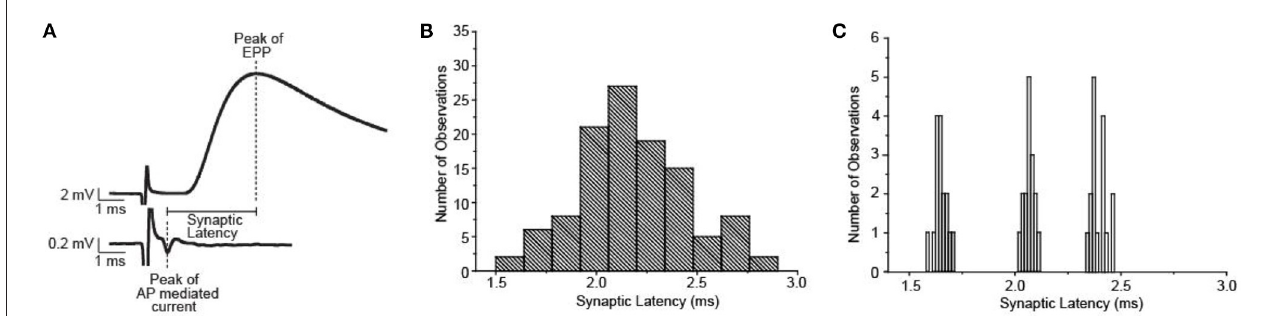
FIGURE 7 | Synaptic delay at the frog NMJ is quite variable between synapses, but not within one synapse. (A) Representative data used to illustrate the method for calculating synaptic delay. (B) Plot of the average synaptic delays measured from 54 frog NMJs. (C) Plot of synaptic delay measured made from 3 of the 54 individual synapses shown in (B) . Repeated measurements ( n = 16) made at each synapse demonstrate little variability within synapses but significant differences between synapses. Adapted from Homan et al.